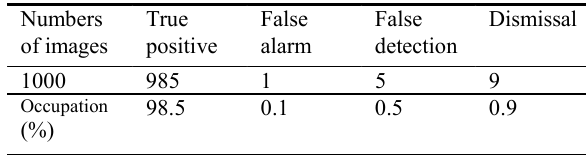
Table 1. Test results of our trained deep network using a dataset of 1000